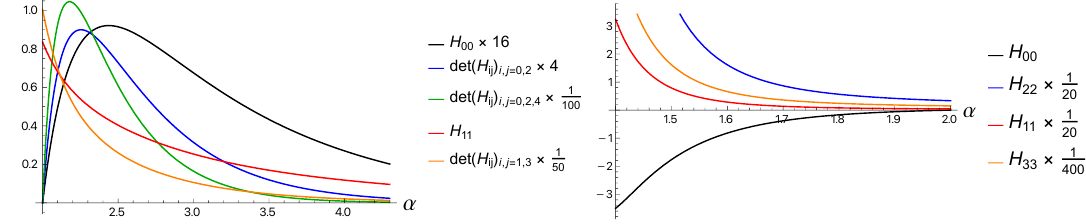
Figure 5 . Hessians for ditches (left panel) and bulges (right panel). The left panel shows the linear stability of the ditches involving the first three even modes and first two odd modes. The right panel shows the bulges are unstable with respect to the first even